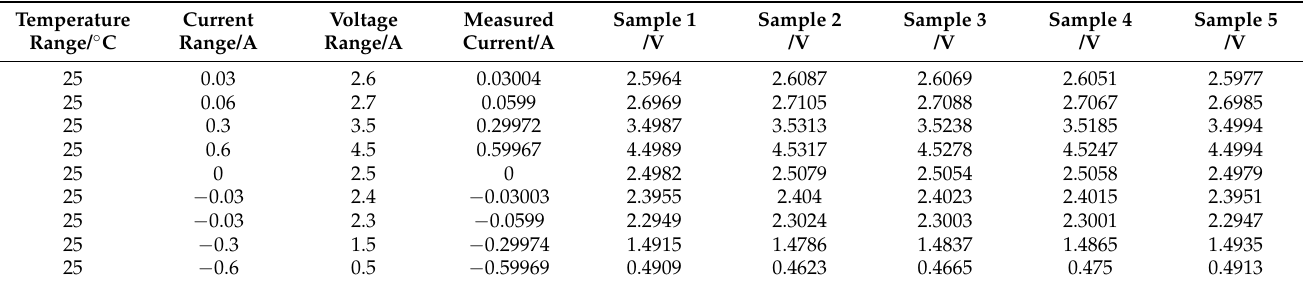
Table 1. DC leakage sensor measurement